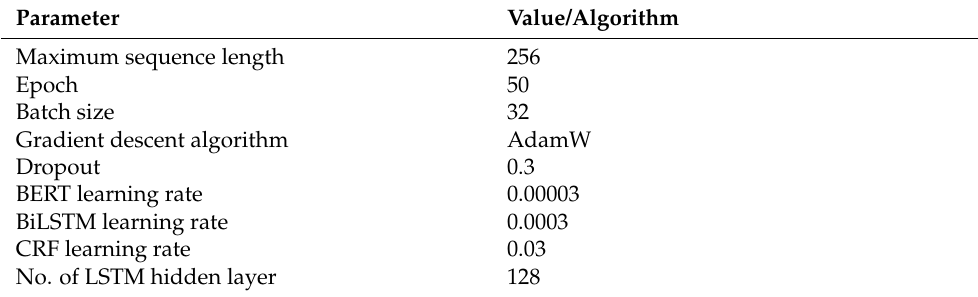
Table 3. Parameter